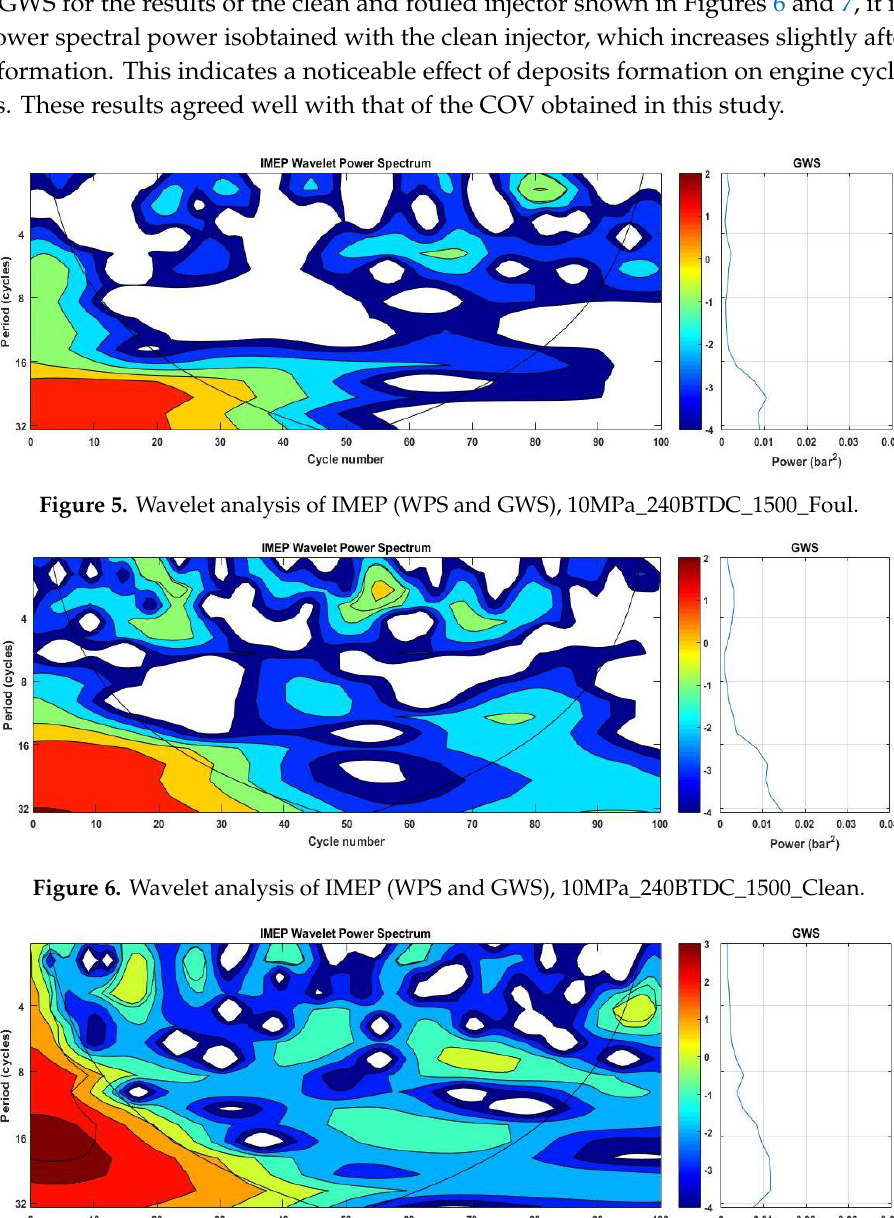
Figure 8. Wavelet analysis of IMEP (WPS and GWS), 10MPa_240BTDC_1720_Clean. Figure 9. Wavelet analysis of IMEP (WPS and GWS), 20MPa_120BTDC_1050_Foul. Figure 10. Wavelet analysis of IMEP (WPS and GWS), 20MPa_120BTDC_1050_Clean.